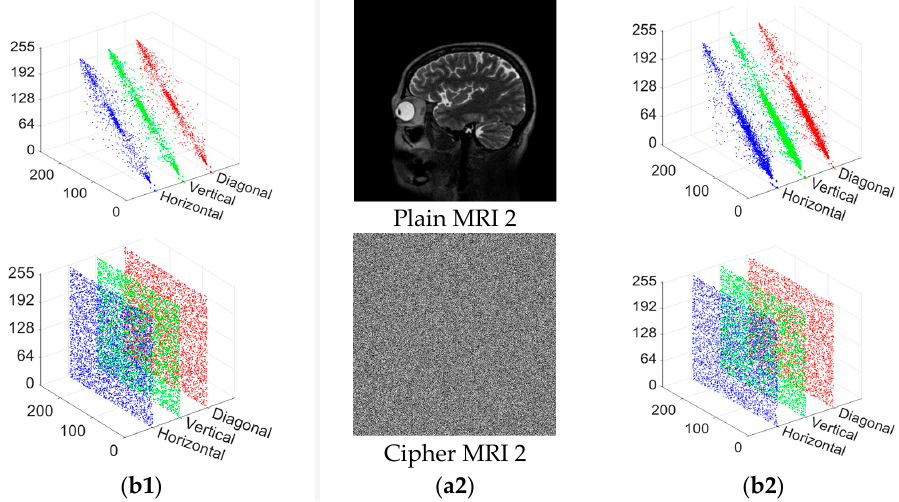
Figure 16. ( a1 , a2 ) Original medical images of size 1024 × 1024 with their encrypted versions and ( b1 , b2 ) the corresponding 4000 pairs of adjacent pixels in the horizontal, vertical, and diagonal directions.